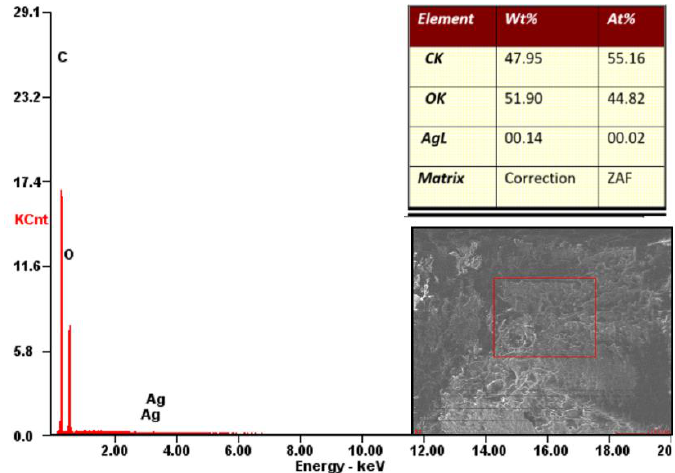
Figure 9. EDX spectroscopic analysis for P2 sample.